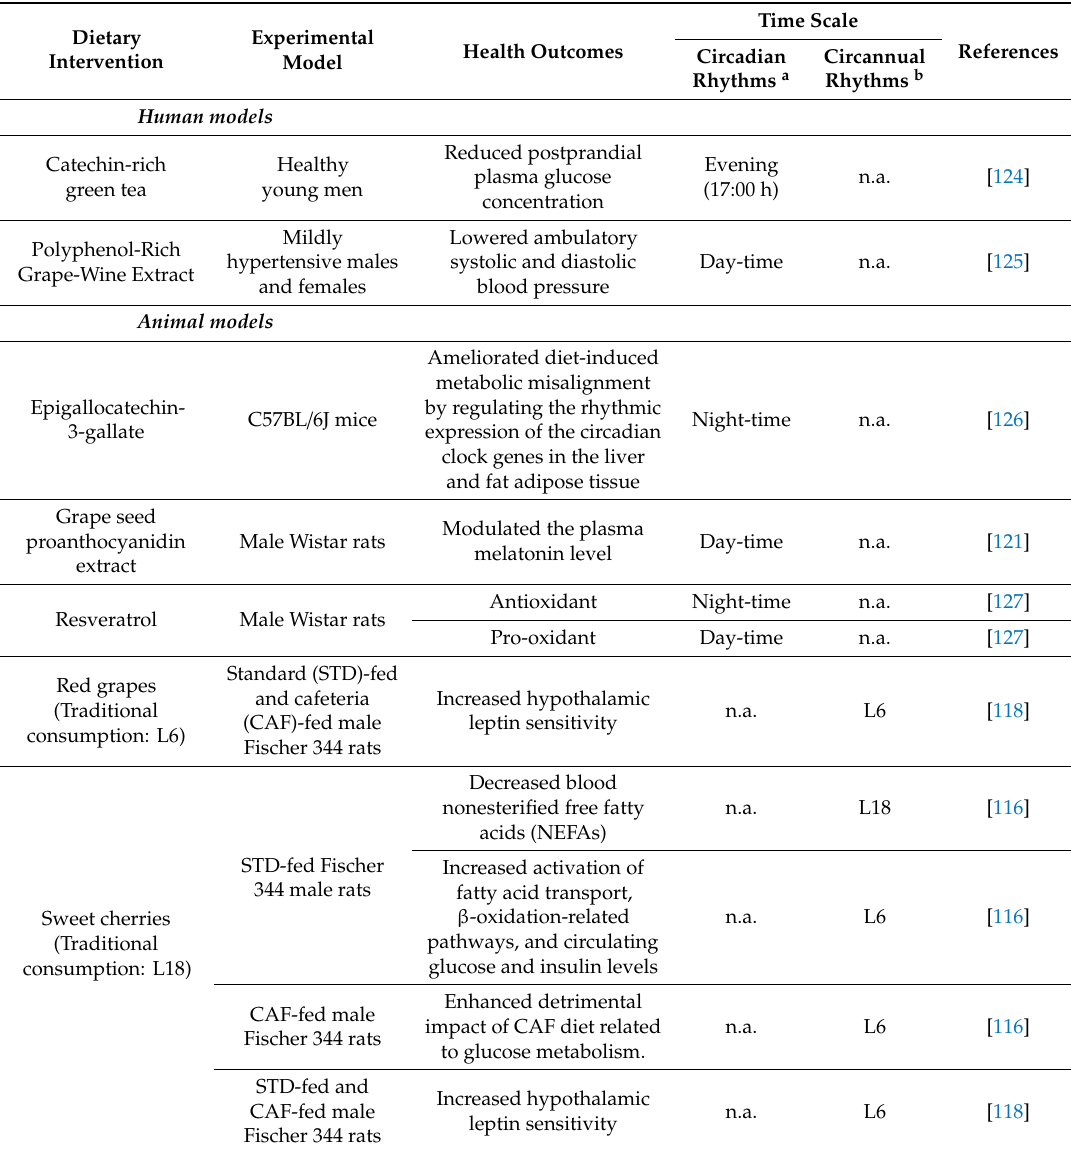
Table 1. Dietary interventions and their health outcomes modulated by circadian and circannual rhythms. Dietary Experimental Intervention